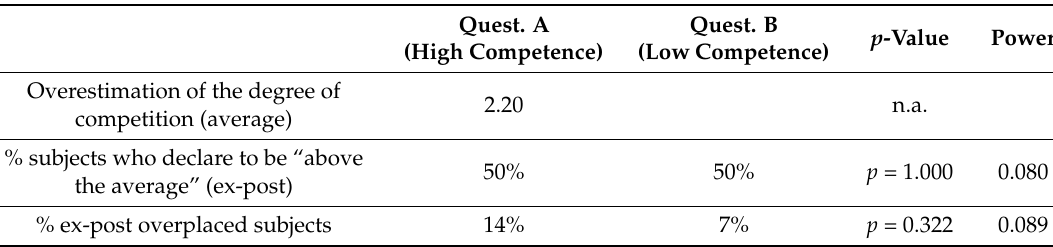
Table 6. The placement and perceived competence in the No Self Selection treatment. Quest.